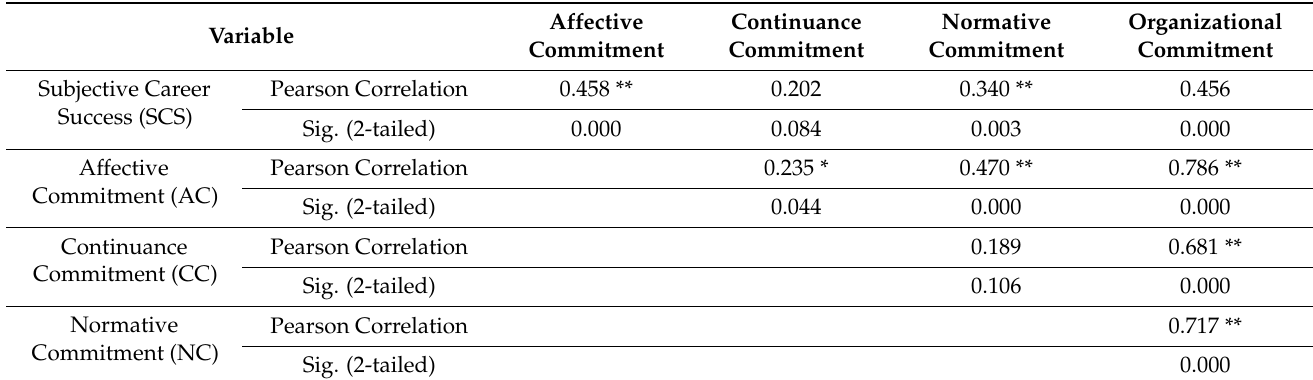
Table 1. Correlation matrix among research variables.